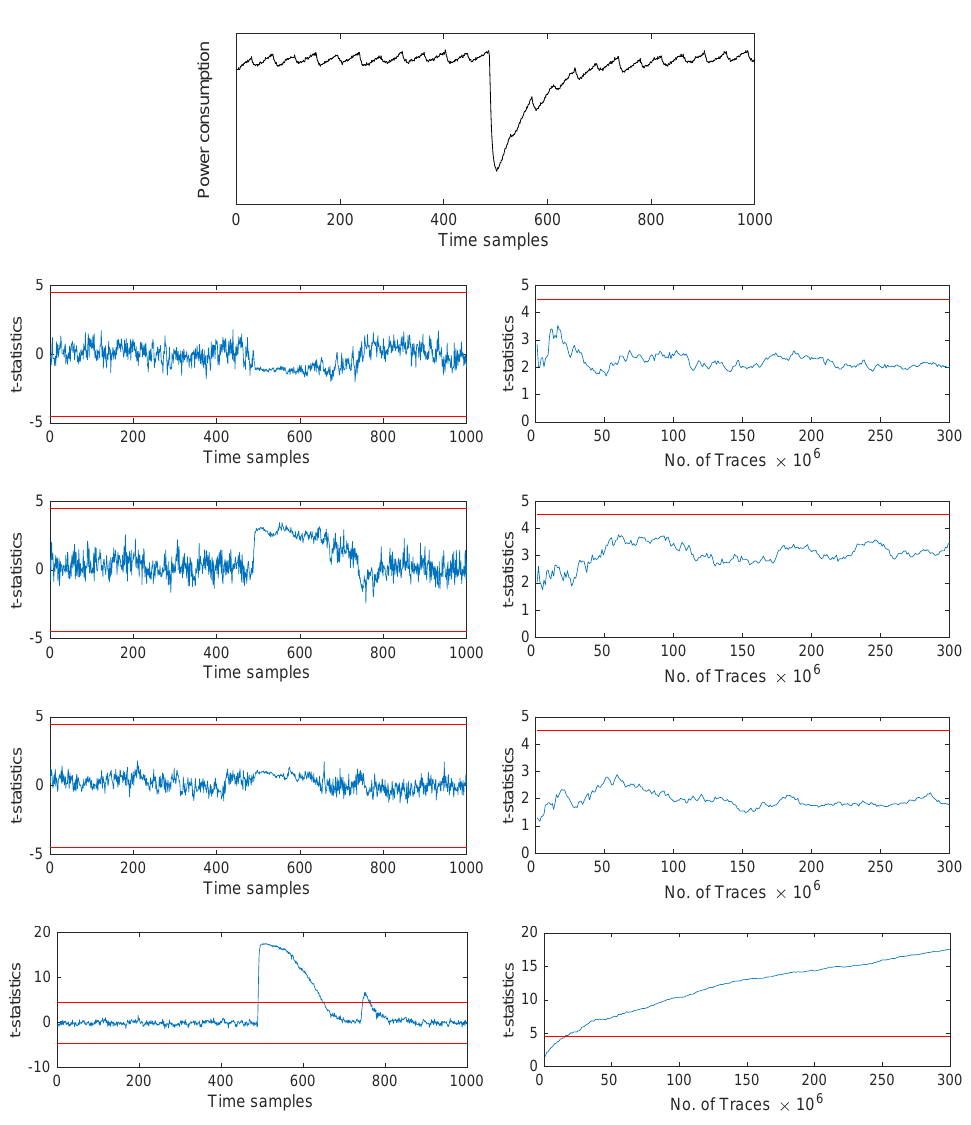
Figure 6: Sample power trace and univariate non-specific t -test results with 300 million measurements for a single GF (2 4 ) multiplier masked by means of CMS with d = 3. The second to fifth rows show the t -statistics for the statistical moments 1 to 4, respectively. The left column depicts the t -values over time, the right column illustrates the evolution of the absolute maximum t -value over the number of